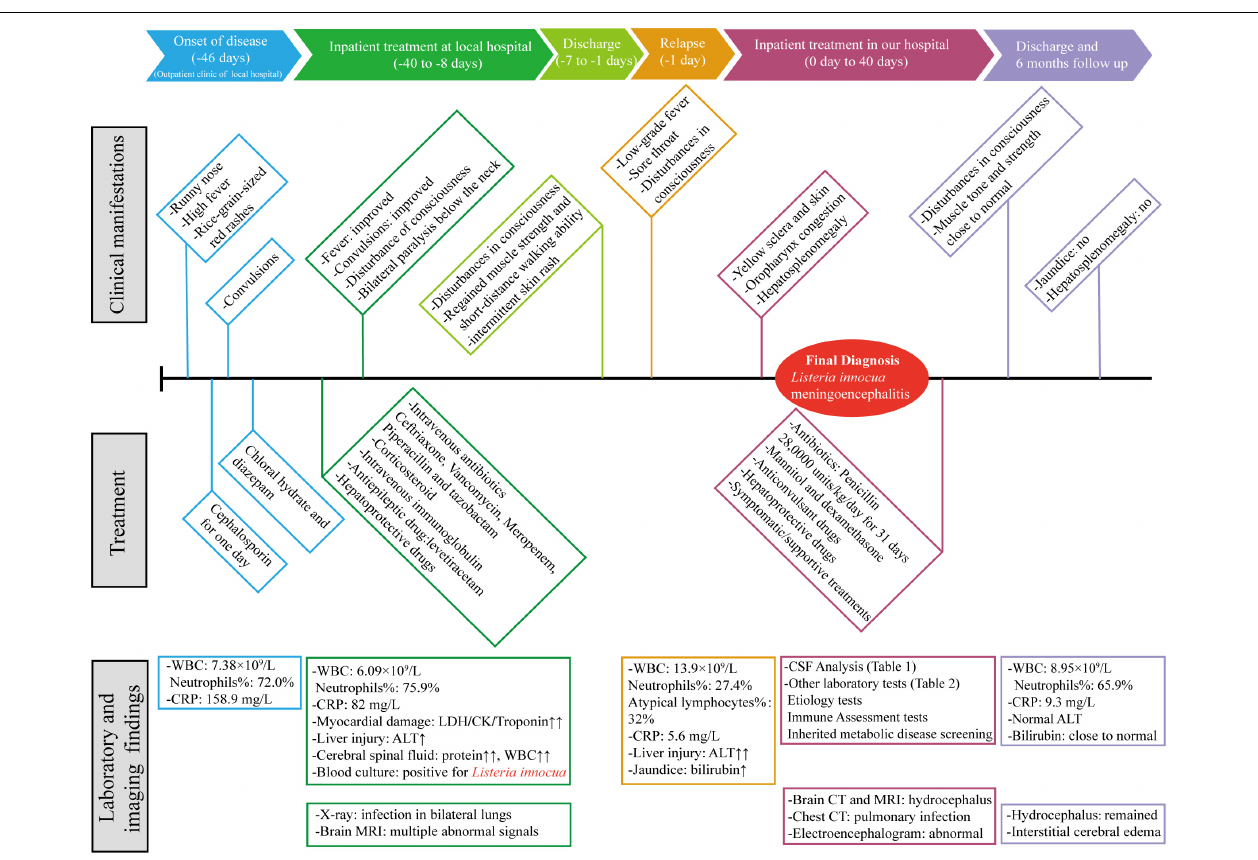
FIGURE 1 | A timeline with relevant data from the patient episode of care. WBC, white blood cell; CRP, C-reactive protein; LDH, lactate dehydrogenase; CK, creatine kinase; ALT, alanine aminotransferase; CSF, Cerebral spinal fluid.